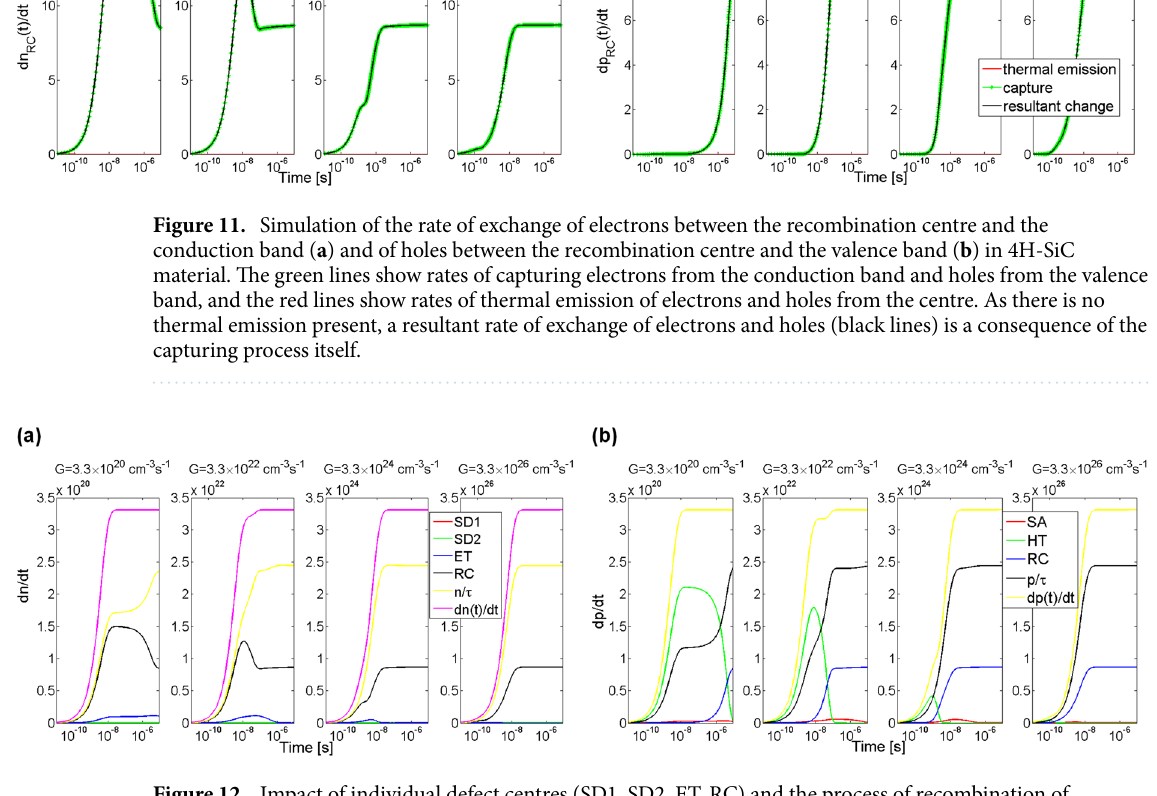
Figure 12. Impact of individual defect centres (SD1, SD2, ET, RC) and the process of recombination of electrons ( n /τ) on the rate of change in concentration of electrons in the conduction band ( a ) and impact of individual defect centres (SA, HT, RC) and process of recombination of holes ( p /τ) on the rate of change in concentration of holes in the valence band ( b ) in 4H-SiC material. Shown data includes both the processes of capture and thermal emission of charge carriers. Parameter G is the generation rate coefficient. Exchange rates between conduction band and the shallow donor defects SD1 and SD2 is